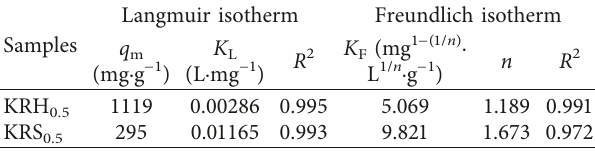
Table 3: Adsorption isotherm parameters.